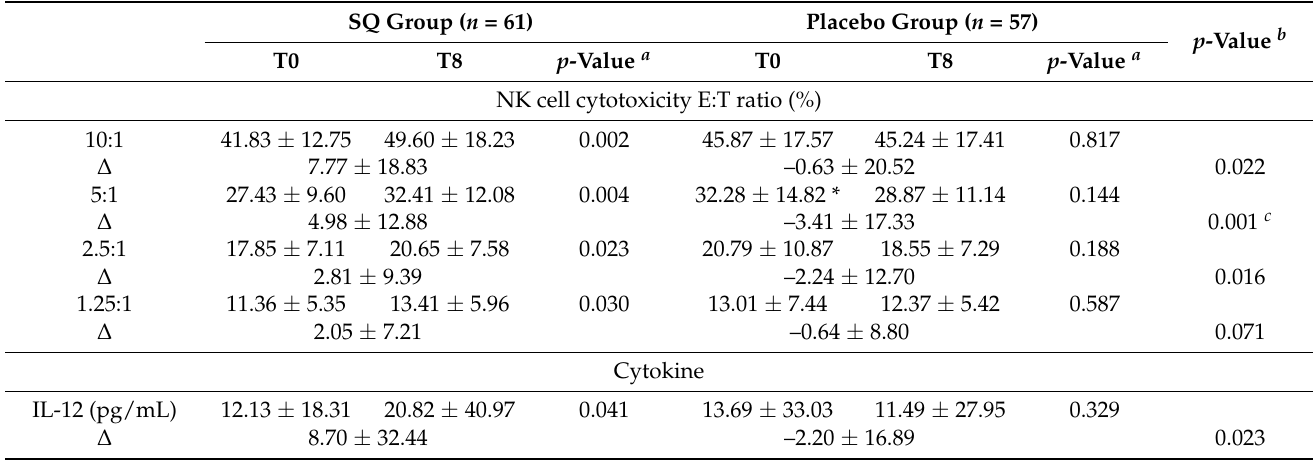
Table 4. Efficacy results of NK cell cytotoxicity and cytokine